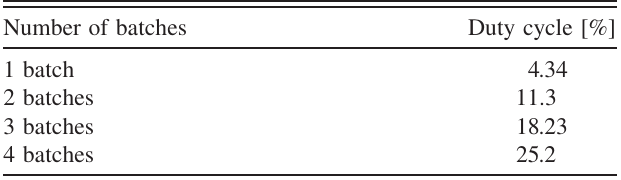
TABLE III. Duty cycle in percent for different beams in the